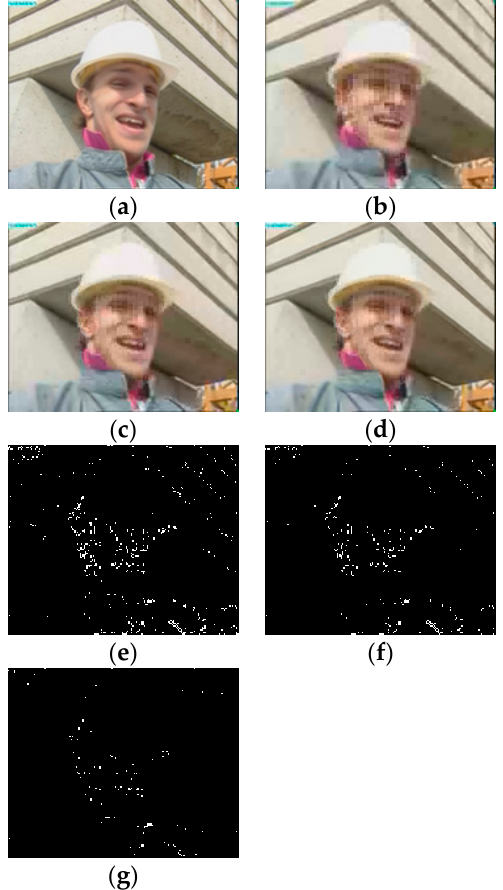
Figure 9. Evaluation of visual quality consistency for the 14 th decoded WZ frame of Foremen sequence obtained by ( a ) Original, ( b ) DISCOVER DVC, ( c ) H.265-DVC, and ( d ) proposed JEM-DVC. The bottom row shows the distortion images between the decoded WZ frames and the original frame, obtained by ( e ) DISCOVER DVC, ( f ) H.265-DVC, and ( g ) proposed JEM-DVC